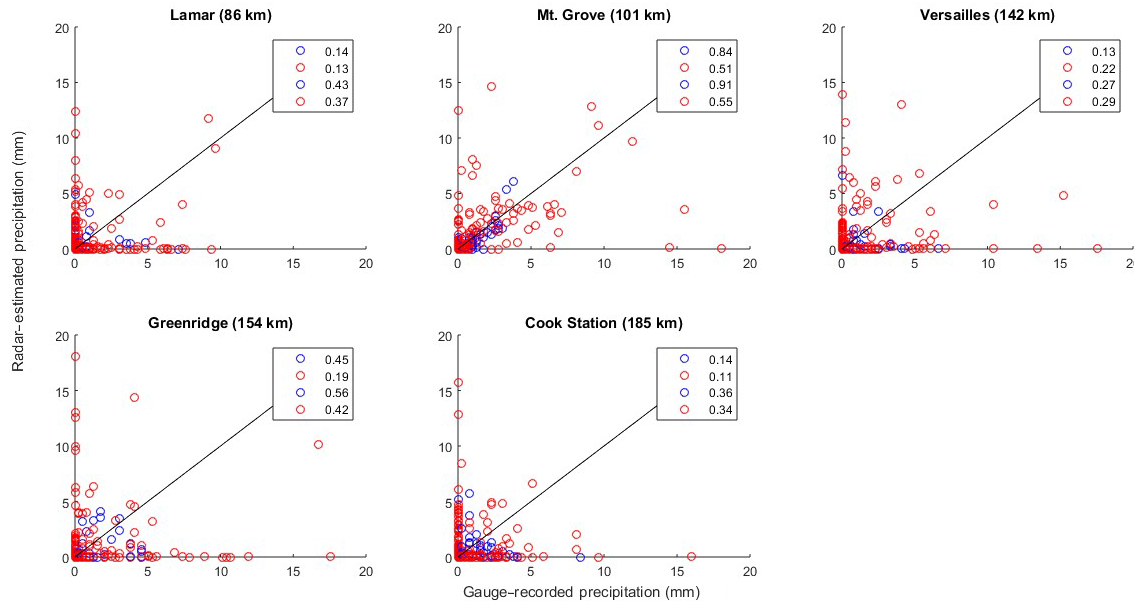
Figure 8. Correlation coefficient values for the five locations analyzed by the Springfield radar with the R ( Z ,ZDR) NSSL equation. Blue and red scatter points represent the cool and warm season data, respectively. The top two numbers on each plot indicate the overall R 2 value, whereas the bottom two numbers represent the R 2 when false alarms and misses are